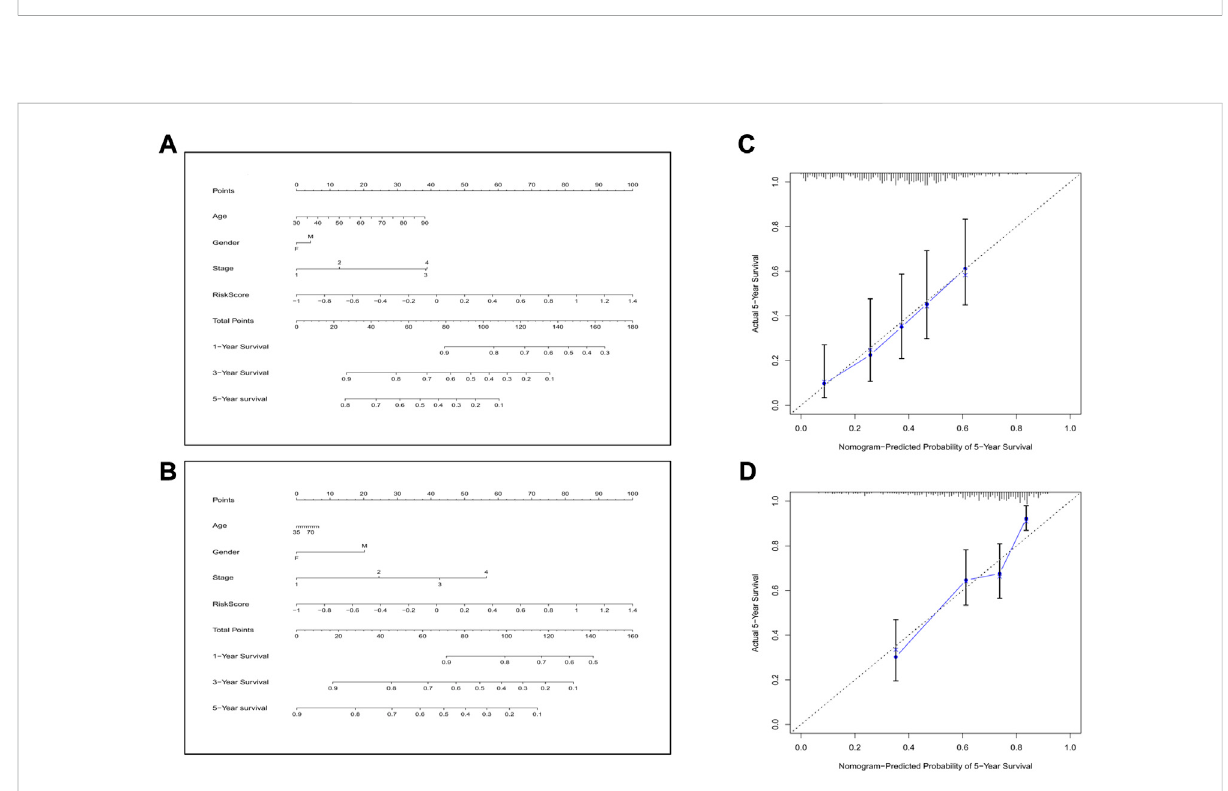
FIGURE 9 Construction of the nomogram and the calibration curve. (A) The nomogram for the training cohort. (B) The nomogram for the validation cohort. (C) The calibration curves for the model in the training set. (D) The calibration curves for the model in the validation set.